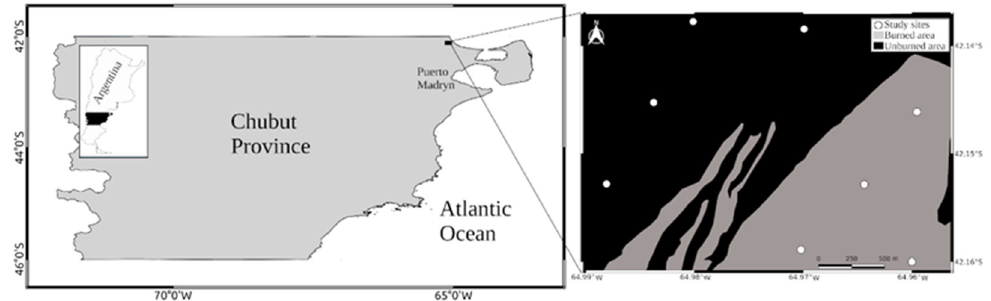
Figure 1. Study area with location of sampling